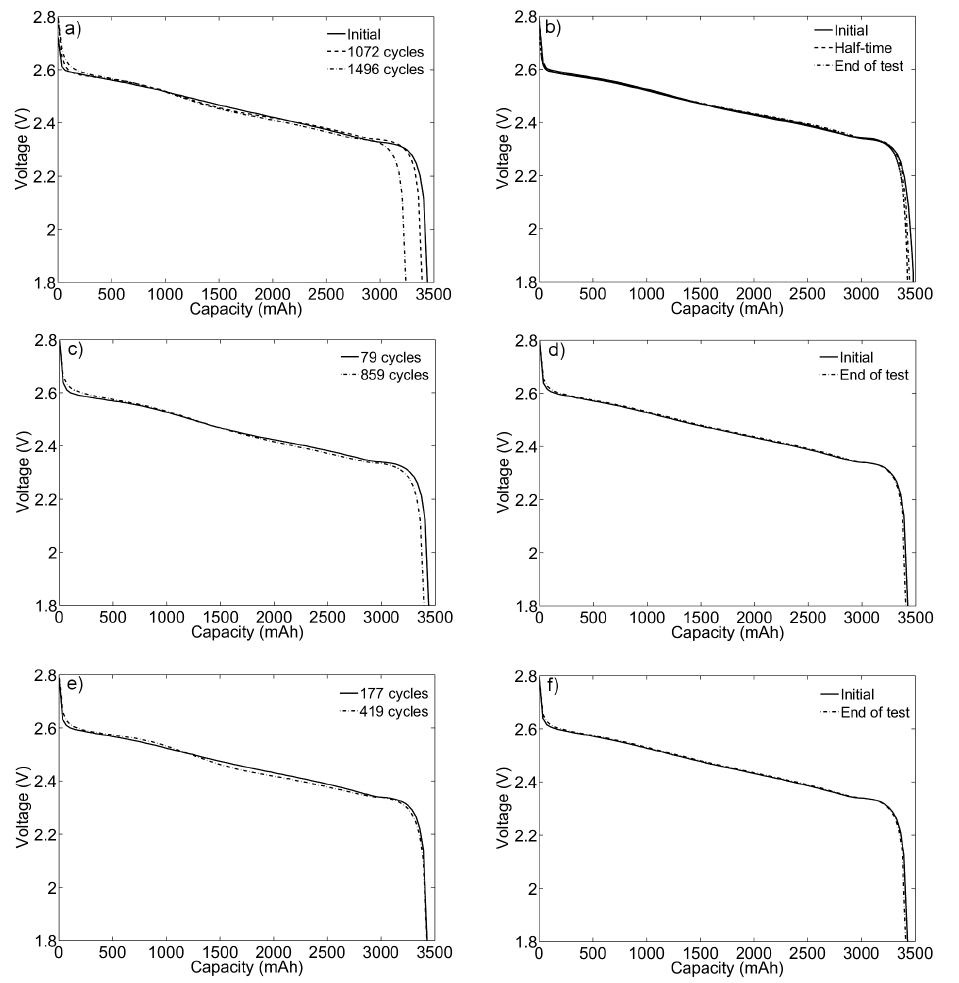
Figure 4. Discharge capacity (C/20) at different equivalent cycles (Neq) for ( a ) cycle aged cell on Truck 1; ( b ) calendar-aged cell on Truck 1 (half-time corresponds to 1072 cycles for the cycle-aged cell); ( c ) cycle-aged cell on Truck 2; ( d ) calendar-aged cell on Truck 2; ( e ) cycle-aged cell on truck 3 and ( f ) calendar-aged cell on Truck